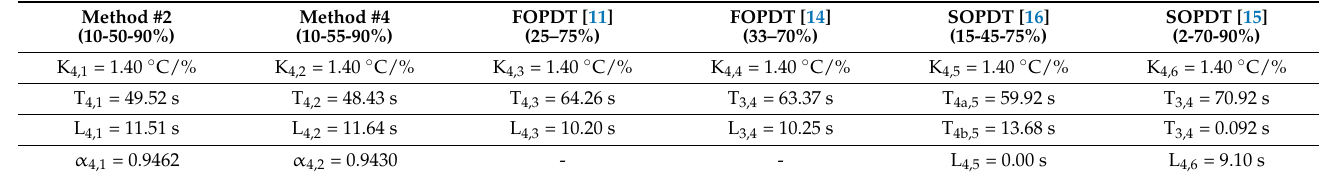
Table 25. Model parameters for the thermal process at the considered operating point obtained using the identification methods #2 and #4 for FFOPDT models, using methods proposed by Alfaro and Vitecková for FOPDT models, and using methods proposed by Stark and Jahanmiri and Fallahi for SOPDT models, respectively.